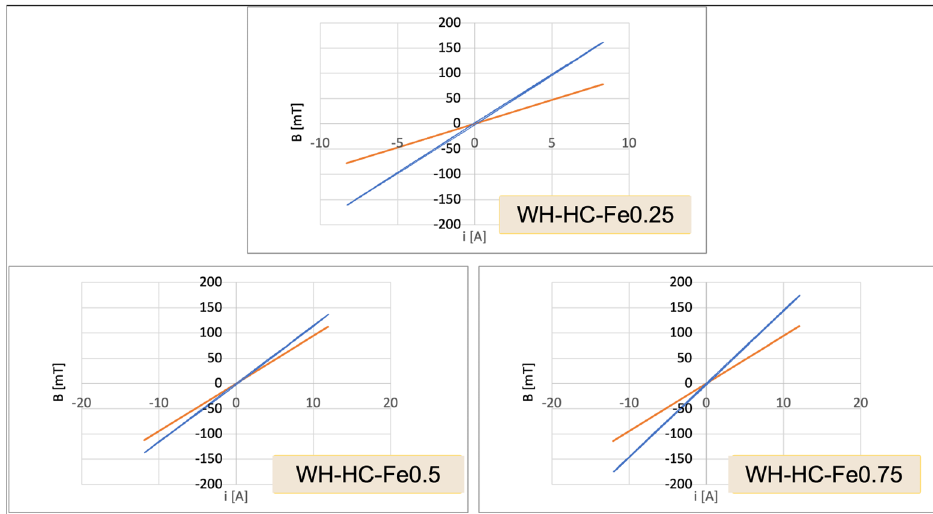
Figure 8. Magnetization curves applied to Fe-catalyzed